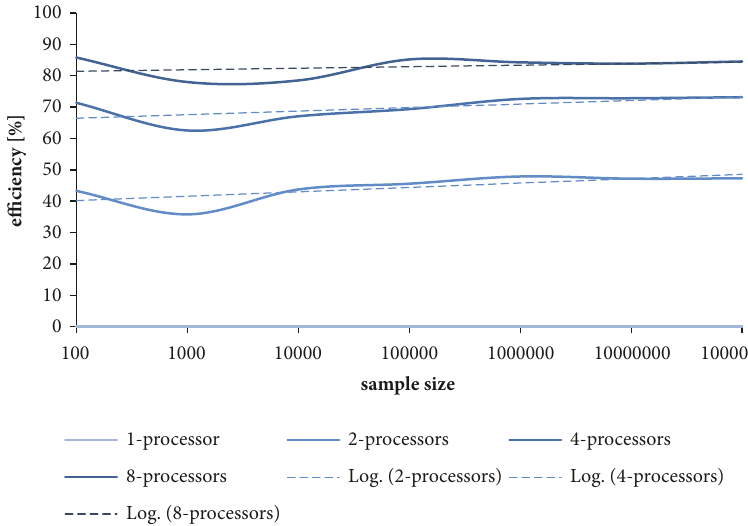
Figure 15: Comparison of the benchmark efficiency using multiple processors in terms of operations [ti].